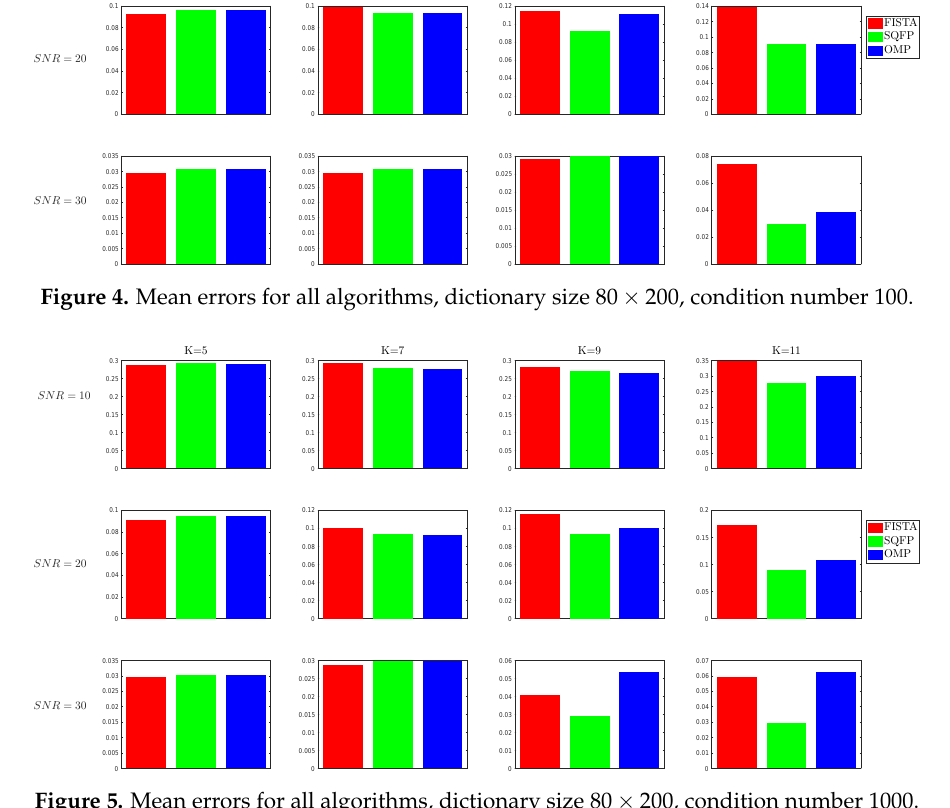
Figure 5. Mean errors for all algorithms, dictionary size 80 × 200, condition number 1000.